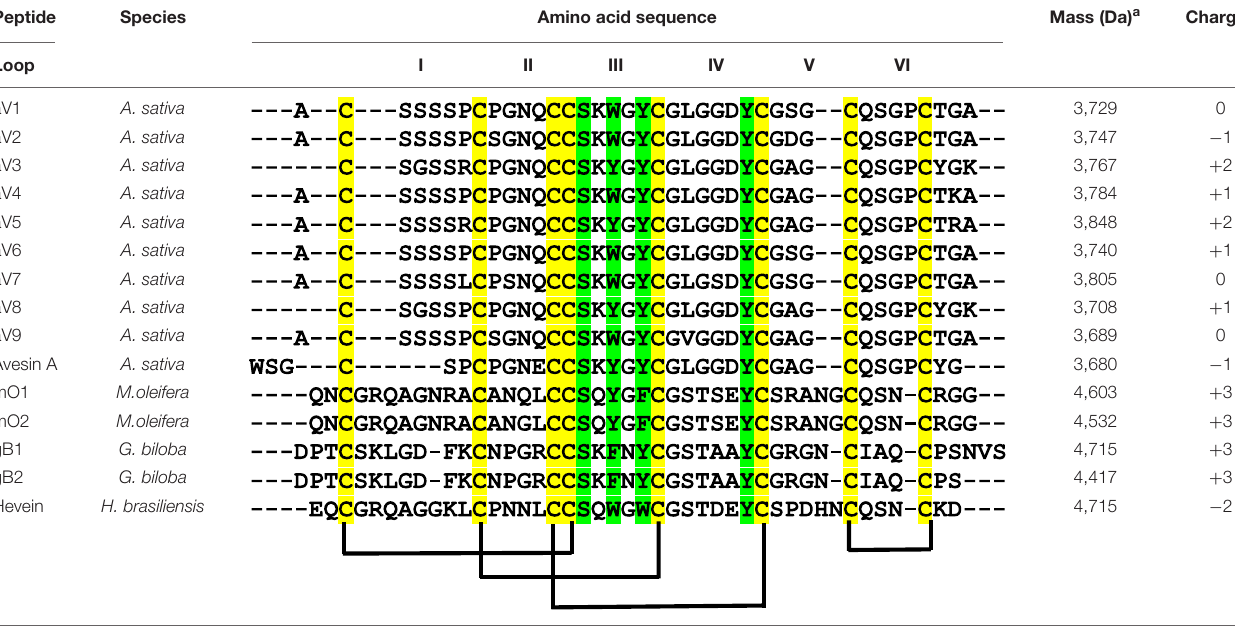
TABLE 1 | Sequence comparison of the mature peptide sequences of avenatides and reported eight-cystine-hevein-like peptides. Peptide Species Amino acid